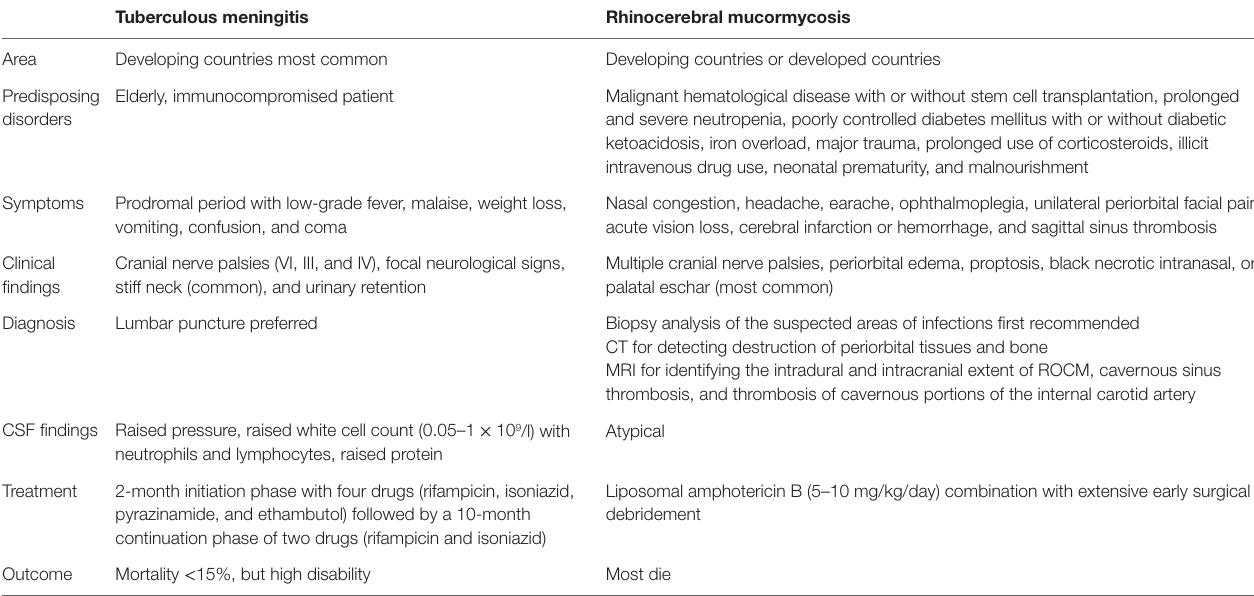
taBLe 1 | Clinical features of tuberculous meningitis and rhinocerebral